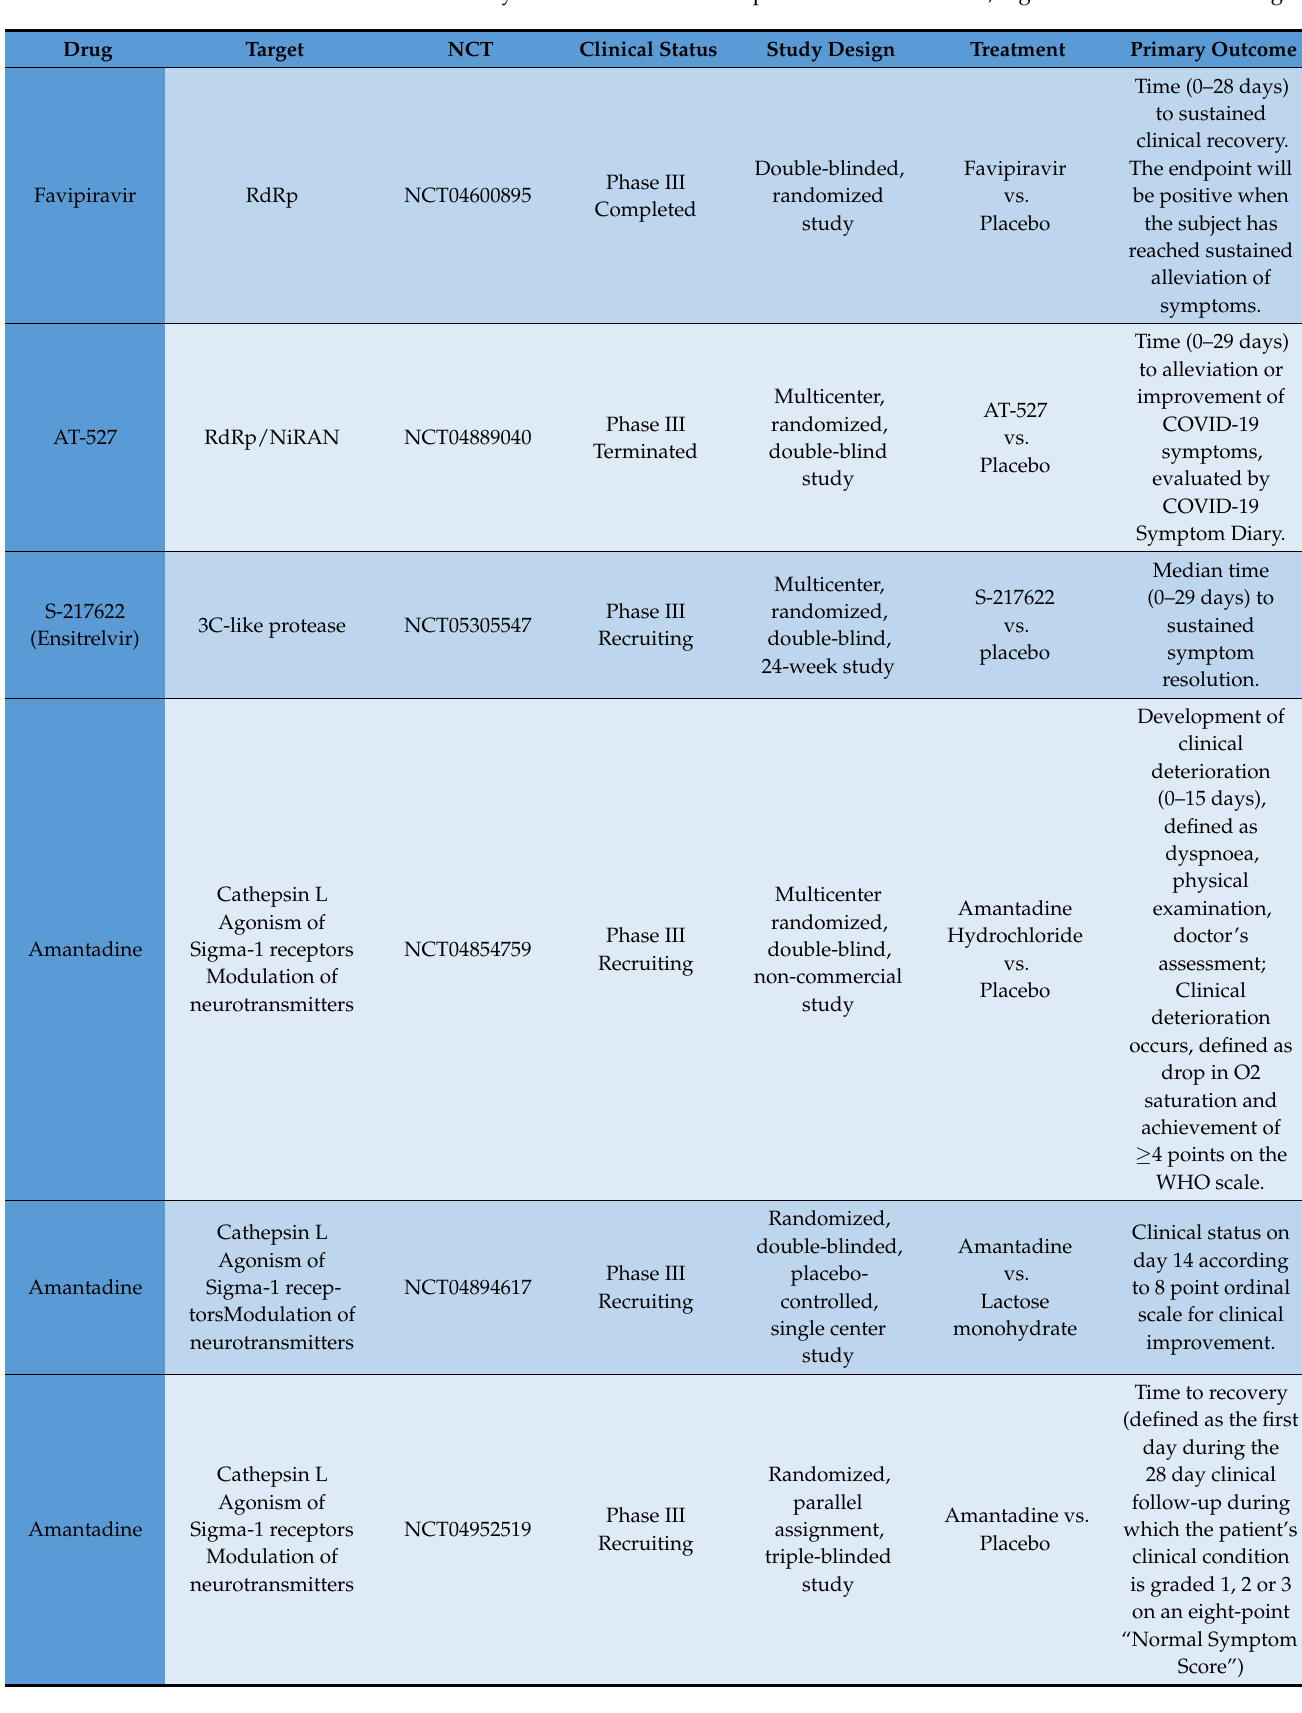
Table 1. Summary of clinical trials of therapeutics for SARS-CoV-2, registered on